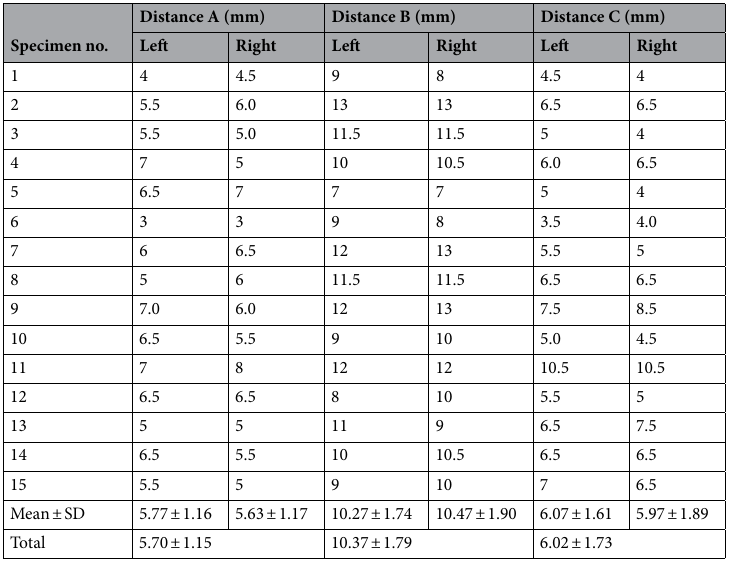
Table 1. Measurements of the distances between bilateral cavernous ICAs to the mid-line of the PG in endoscopic view. Distance A represents the distance from the medial border of the subarachnoid segment of the ICA to the mid-line of the PG. Distance B is the distance between the medial border of the anterior vertical segment of cavernous ICA to the mid-line of the PG. Distance C marks the distance from the medial border of the inferior horizontal segment of the ICA to the mid-line of the PG.